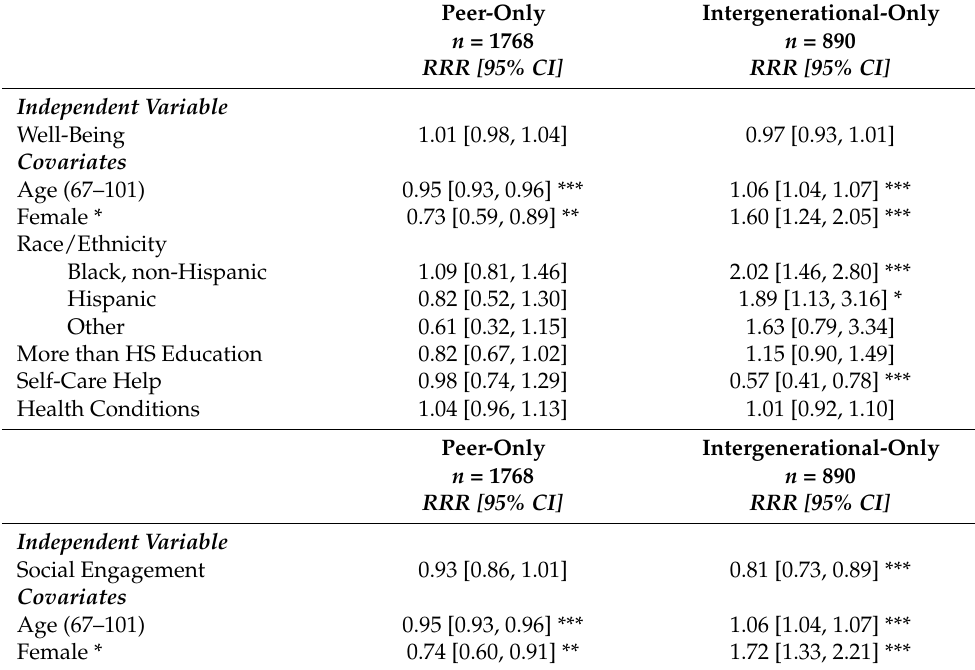
Table A3. Weighted Multinomial Logistic Regression, Well-Being and Social Engagement on